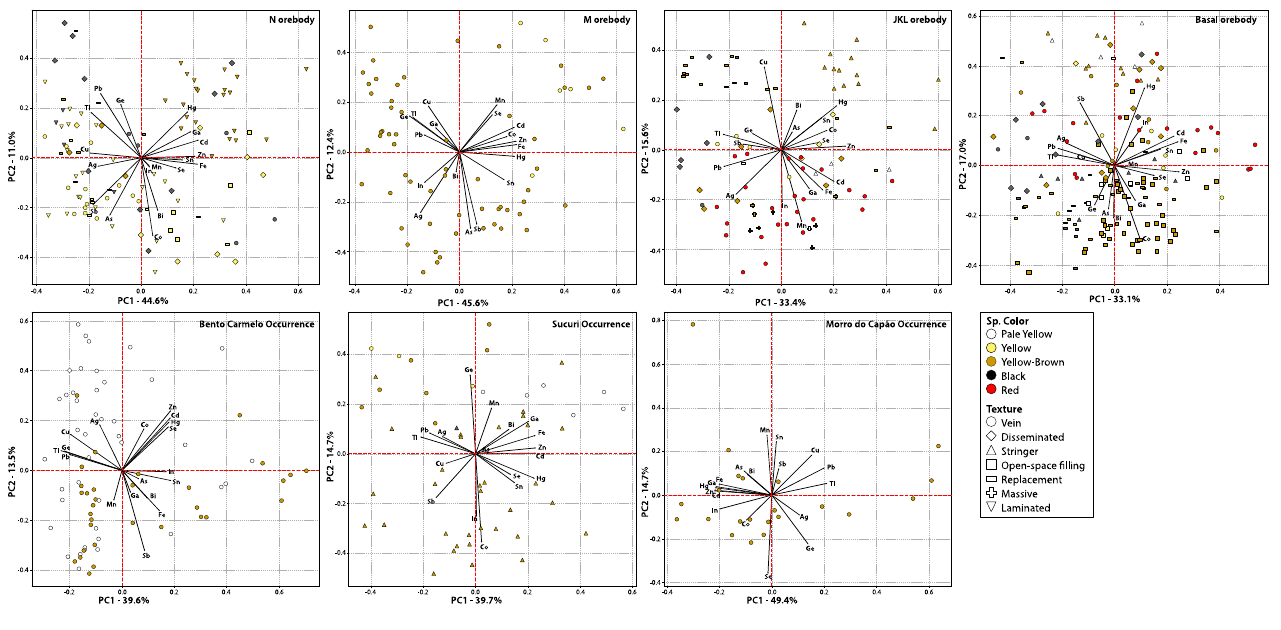
Figure 12. Principal components (PC1 vs. PC2) of sphalerite mineral chemistry from the various orebodies of the Morro Agudo deposit and minor occurrences in the district. Using a subset of the elemental dataset containing only the elements Ag, Co, Cu,